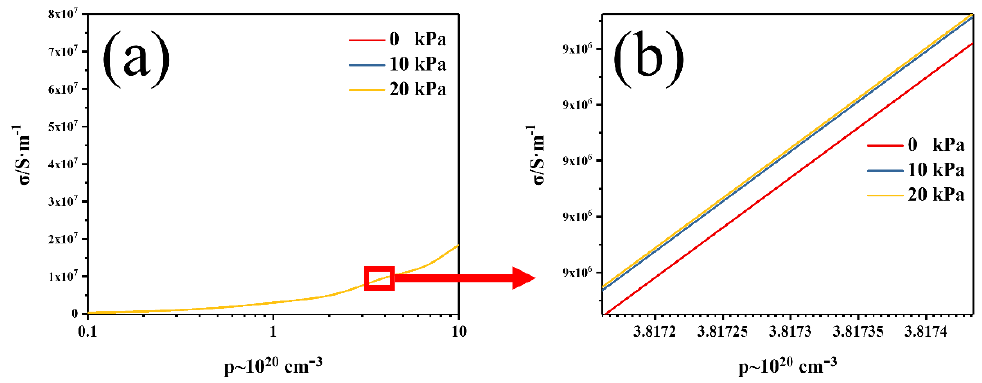
Figure 6. ( a ) The carrier-concentration-dependent electrical conductivities for perovskite CsPbI 3 under pressure 0, 10 and 20 kPa. ( b ) is a partial enlargement of ( a ).